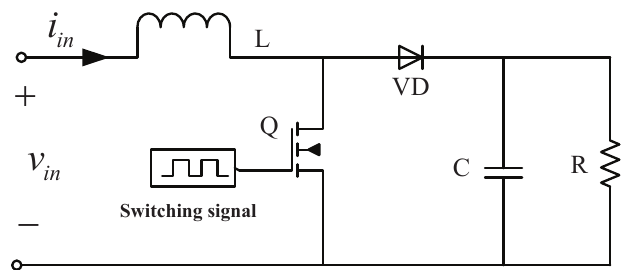
Figure 2. The topology of DC-DC boost